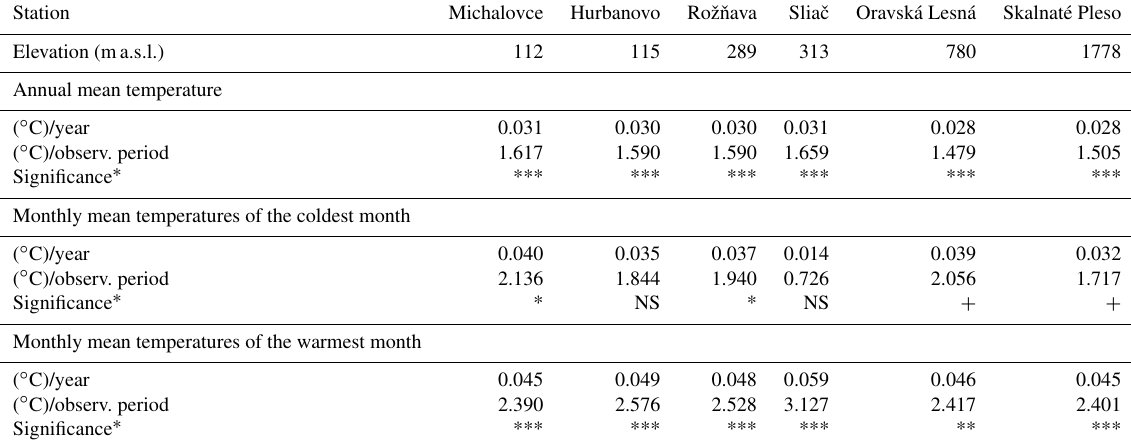
Table 2. The linear trend values (( ◦ C)/year; ( ◦ C)/observed period) and statistical significance levels of annual mean temperature, monthly mean temperatures of the coldest and warmest month, for the six meteorological stations.